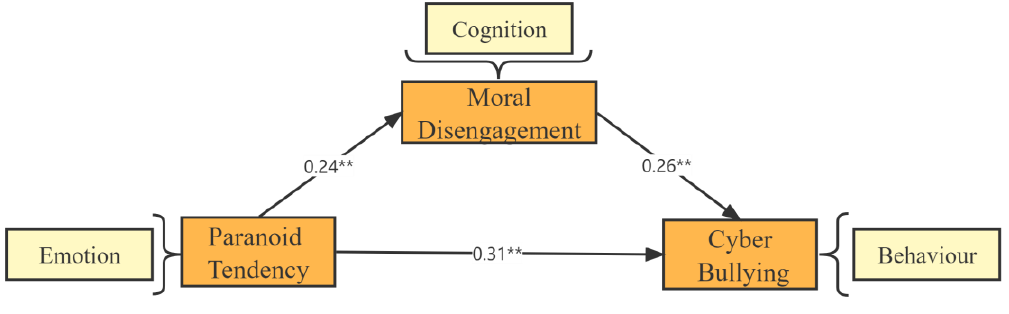
Figure 2. Intermediary effect diagram.